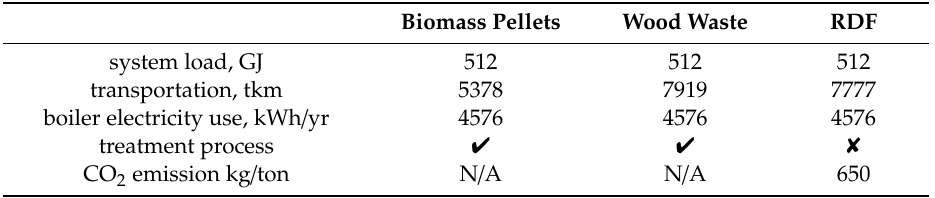
Figure 9. System boundary for the LCA implementation. Table 8. Input data for life cycle analysis (LCA) of biomass pellets, wood waste, and RDF